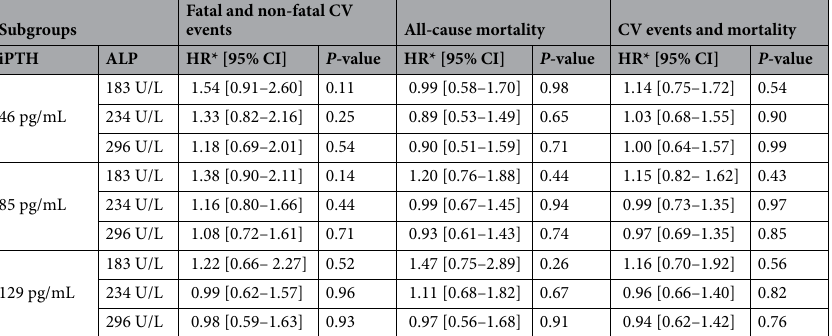
Table 2. Hazard ratios for cardiovascular events and deaths in the alfacalcidol group based on both ALP and PTH. iPTH intact parathyroid hormone, ALP alkaline phosphatase, HR hazard ratio, CI confidence interval. *HR in the alfacalcidol group vs the control group at each specified iPTH and ALP